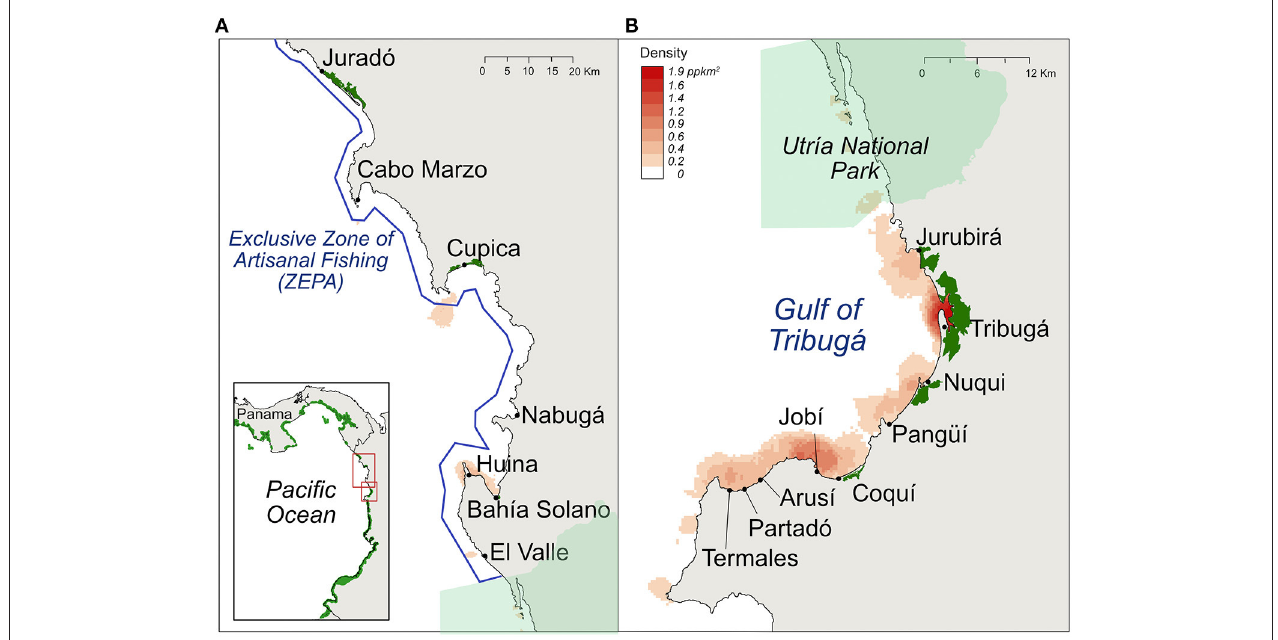
FIGURE 1 | (A) Study site location in the Northern Chocó region on the Pacific coast of Colombia (red square, inset). Solid black circles represent artisanal fisheries landing sites included in this study. Blue line represents the Exclusive Zone of Artisanal Fishing (ZEPA). Mangroves are shown in green. Red shading corresponds to density estimation of fishing grounds showing the distribution of fishing sites per km 2 in (A) the ZEPA and (B) the Gulf of Tribugá. Dark red areas represent high fishing ground density and light red represents low